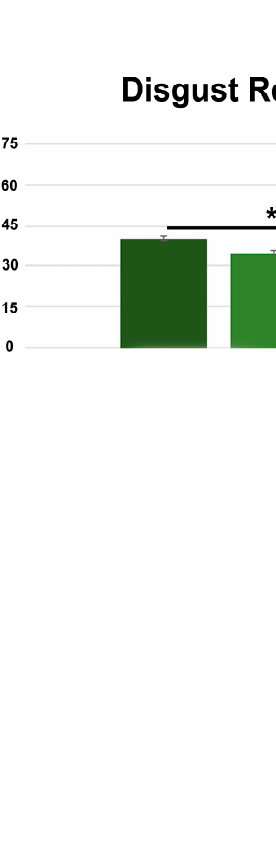
Table 1. Peak coordinates of functional activation related to incongruent